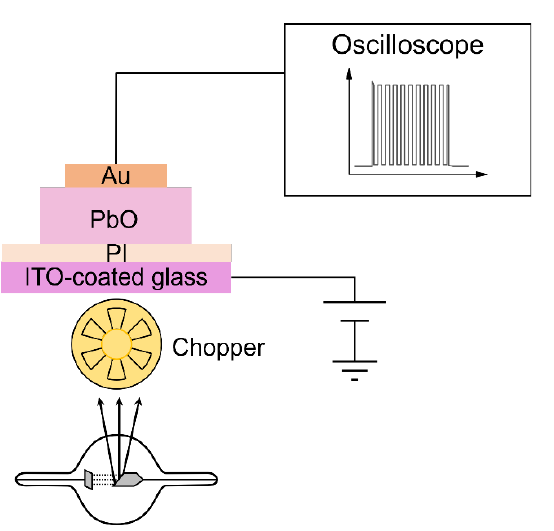
Figure 3. Schematics of pulsed mode XPM setup used to characterize temporal performance (not to scale).